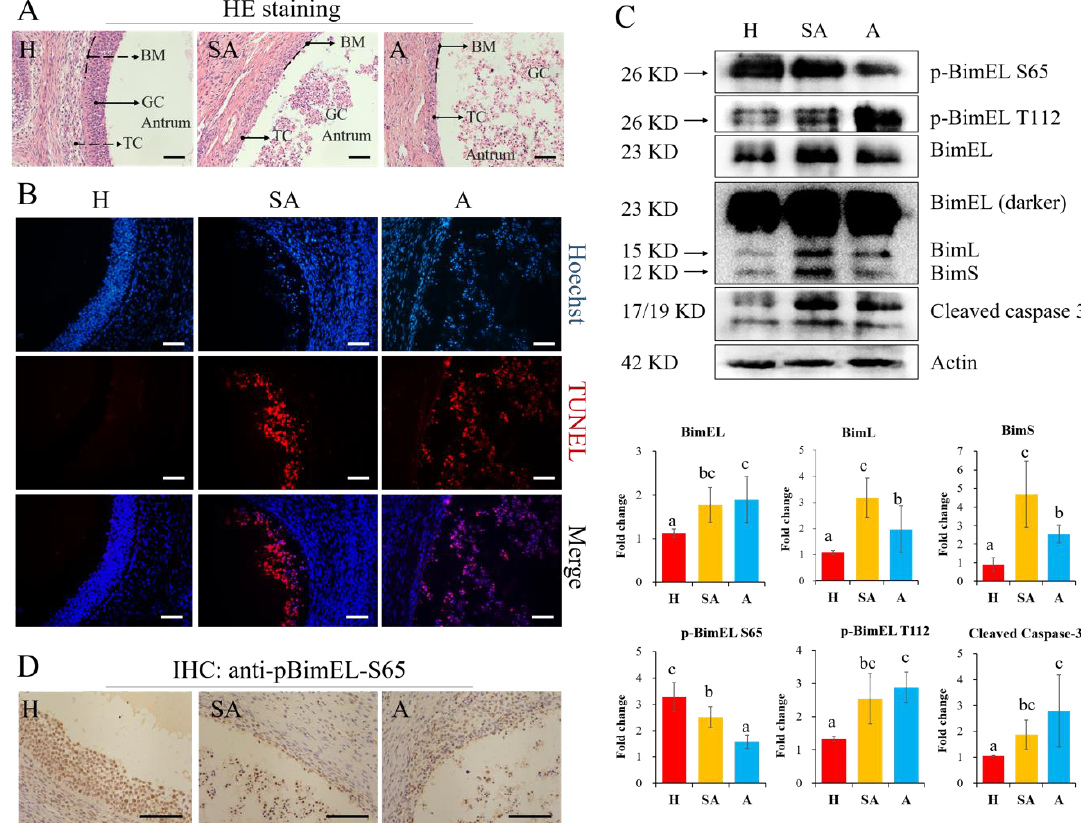
Figure 2. Levels of p-BimEL-S65 were decreased while p-BimEL-T112 were increased in granulosa cells during follicular atresia. ( A ) Hematoxylin–eosin (HE) staining of porcine healthy, slightly atretic and atretic follicle. Scale bar = 100 µ m. BM = basement membrane, GC = granulosa cell, TC = theca cell. ( B ) Hoechst and TUNEL staining of follicles with di ff erent status. Scale bar = 100 µ m. ( C ) Granulosa cells obtained from porcine healthy, slightly atretic, and atretic follicles were analyzed by Western blotting. Actin is the loading control. Column charts show the quantitative analysis of p-BimEL S65, p-BimEL T112, BimEL, BimL, BimS, and cleaved caspase-3. The data are representative of three independent experiments. Values are expressed as the means ± SD of three separate experiments. The bars are labeled with completely di ff erent letters indicating significant di ff erence, p < 0.05. ( D ) p-BimEL-S65 protein was localized with specific antibodies by immunohistochemistry (IHC). Scale bar = 100 µ m. H = healthy follicle; SA = slightly-atretic follicle; A = atretic follicle, p-BimEL S65 = phosphor-BimEL-Ser65; p-BimEL T112 =